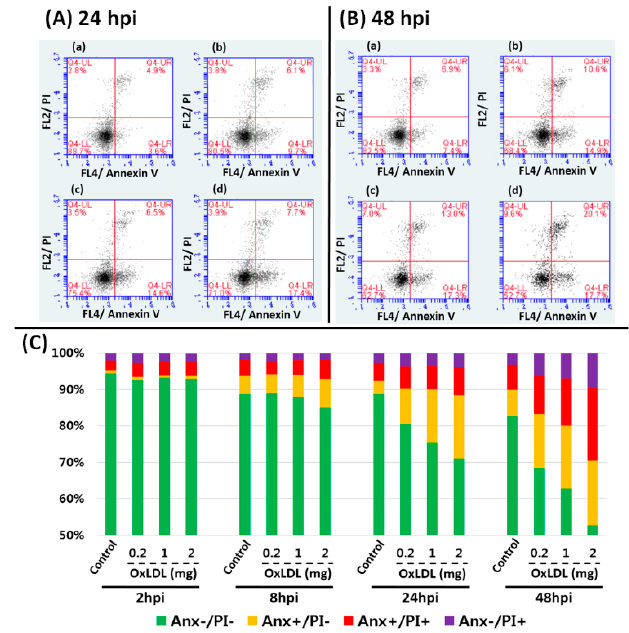
Figure 6. The scattergrams of FL-2 (PI) plotted against FL-4 (Anx V) fluorescence of the leukocytes under ( A ( a )) and ( B ( a )) 0 (control); ( A ( b )) and ( B ( b )) 0.2; ( A ( c )) and ( B ( c )) 1, and ( A ( d )) and ( B ( d )) 2 mg/mL OxLDL treatment at 24 and 48 hpi, respectively. ( C ) The percentage of Anx V - /PI - , Anx V + /PI - , Anx V + /PI + , and Anx V - /PI + , at 2, 8, 24, and 48 hpi are indicated in the cumulative bar graph.